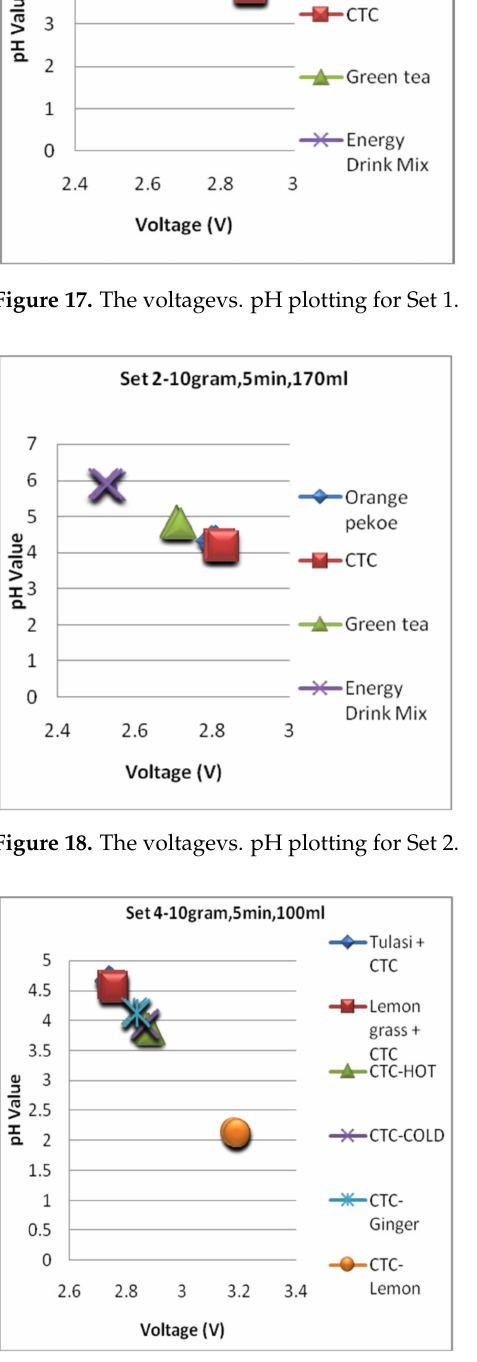
Figure 19. The voltagevs. pH plotting for Set